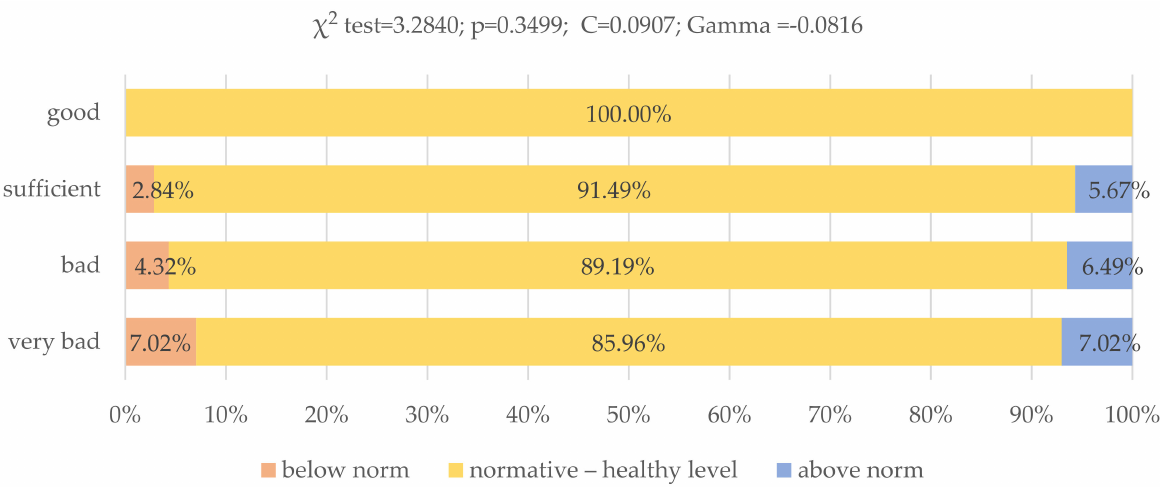
Figure 6. Assessment of nutritional behavior of young Poles and their level of total body water ( N = 399). * When assessing the level of body fat, the gender of the respondents was taken into account. Source: own study based on the research.